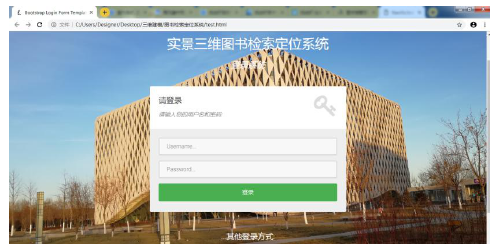
Figure 13. Real-scene three-dimensional book retrieval